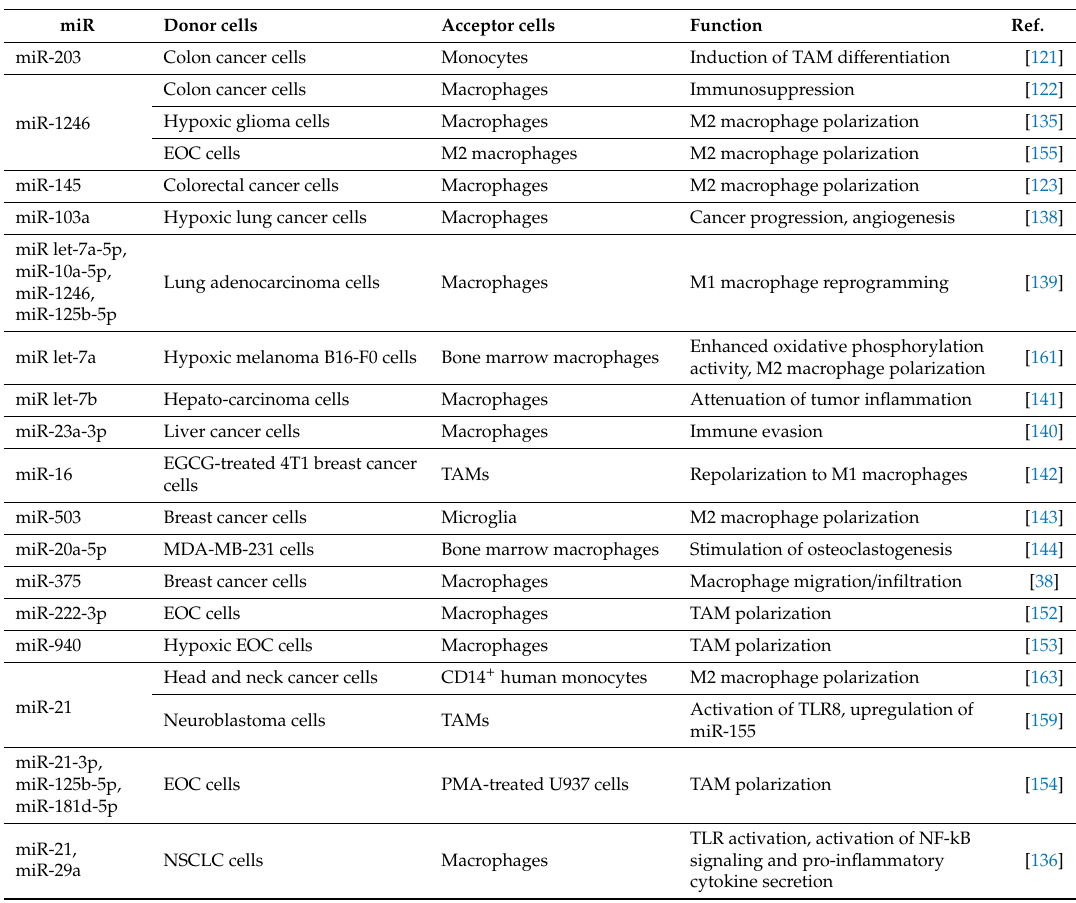
Table 1. MiR-mediated cross-communication between tumor cells and